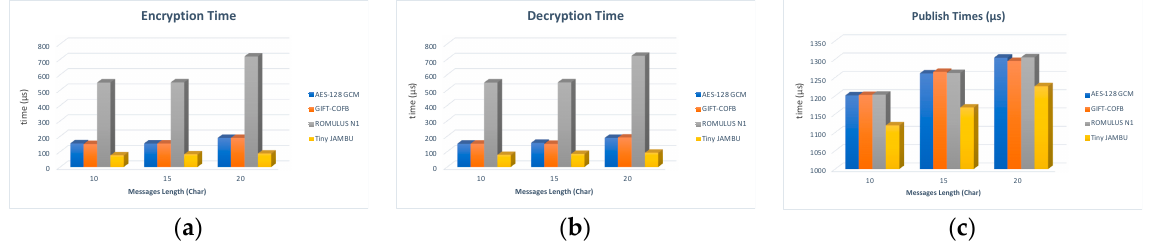
Figure 8. Lightweight Cryptographic Encryption and Decryption Performance on STM32L4 on